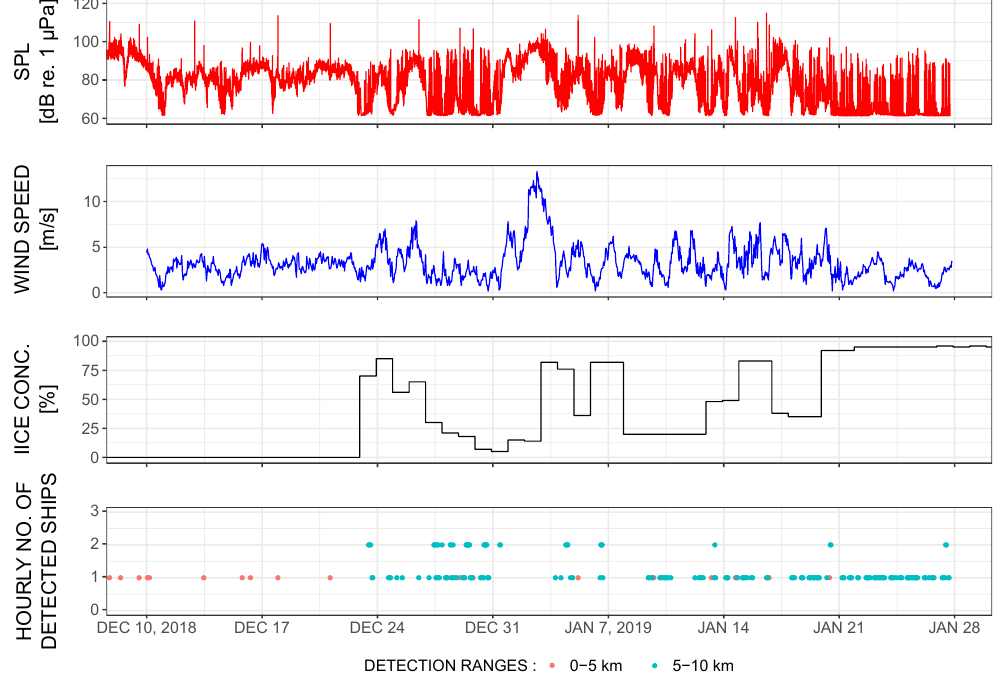
Figure 8. Time series of 500 Hz TOB sound pressure level (SPL), wind speed, ice concentration, and detections of AIS-equipped ships grouped in two categories according to their detection ranges. SPL correlates with the wind speed, and long-range detections start with the appearance of ice